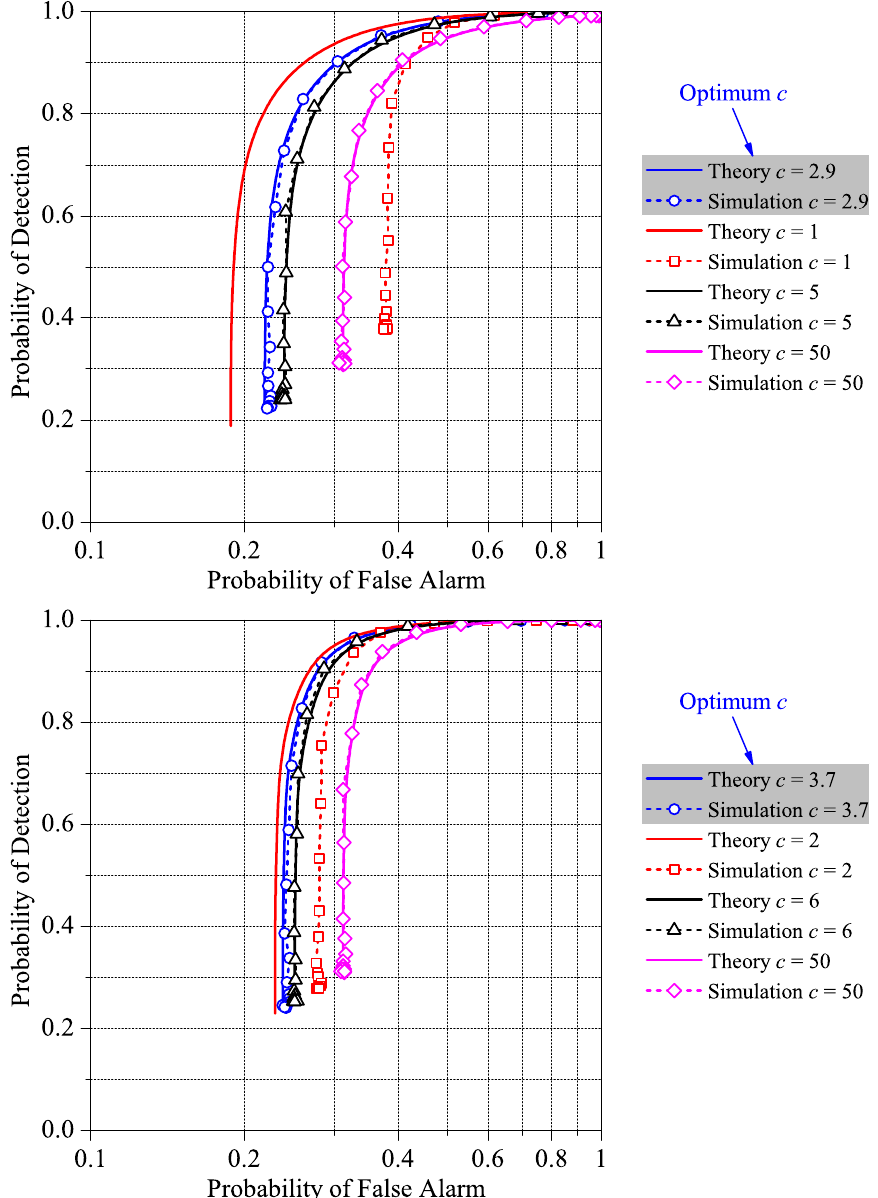
Figure 5. Theoretical and simulated ROC curves of the proposed fusion scheme for M = 3 ( Top ), M = 5 ( Bottom ), K = 1 and different clipping